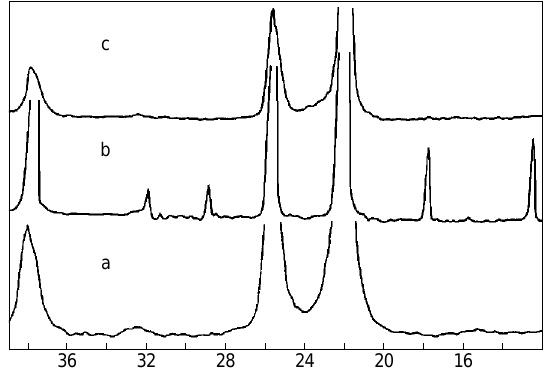
Fig. 11 X-ray patterns of Ni 13 wt.% Al samples: obtained from a metal powder mixture by mechanical alloying for 15 min. (a), obtained by SHS (b), the SHS product after mechani- cal activation during 1 min.